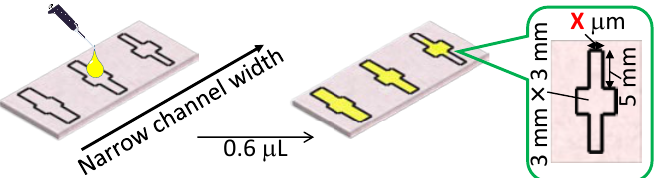
Figure 4. Schematic of the experimental method used to evaluate the minimally required width of microfluidic channels aligned to the cellulose fiber direction in the filter paper. The indicated dimensions refer to the values set for wax printing and do not represent the actual dimensions obtained after hot lamination.